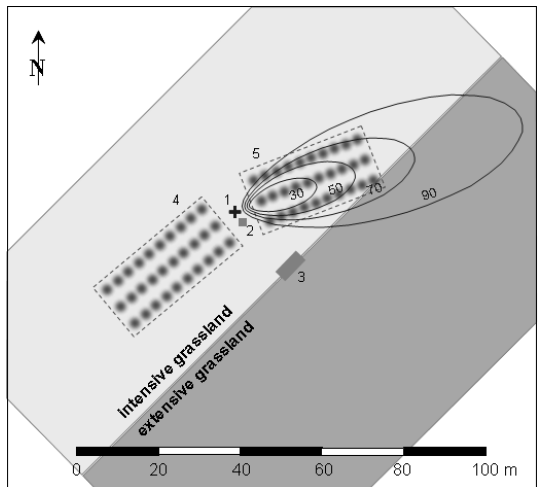
Fig. 1. Schematic map of the experimental field setup. (1) position of both EC flux systems: sonic anemometers and sample tube inlets for QCLAS and FMA; (2) weatherproof housing with the FMA; (3) trailer housing the QCLAS; (4) and (5) alternate positions of fumi- gation grids for the two main wind directions: circles indicate the position of the 30 release orifices, the dashed enveloping rectangle represents the source area used in the footprint calculation (assum- ing a constant average emission flux). The contour lines illustrate the flux footprint with 30%, 50%, 70%, and 90% flux contribution for a northeasterly wind case on 31 March 2009 11:00–14:30CEST ( u = 3 . 8ms − 1 , z/L =− 0 .